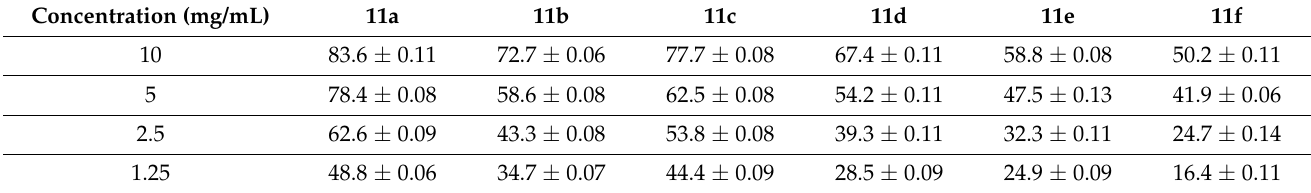
Table 8. Anti-biofilm assay of conjugates of 11 towards MRSA ATCC 43300. Experiment evaluated based on quadruplicate results with standard deviation. (n =